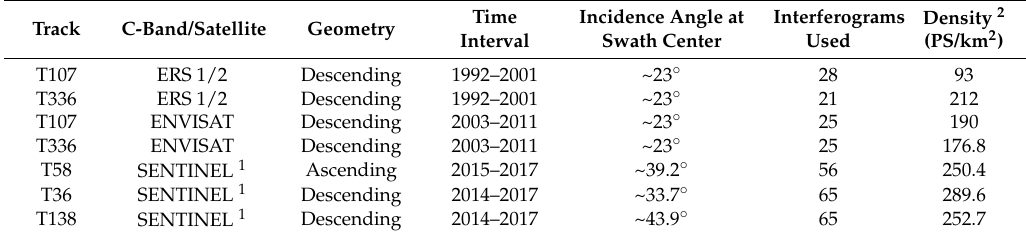
Table 1. Characteristics of each processed